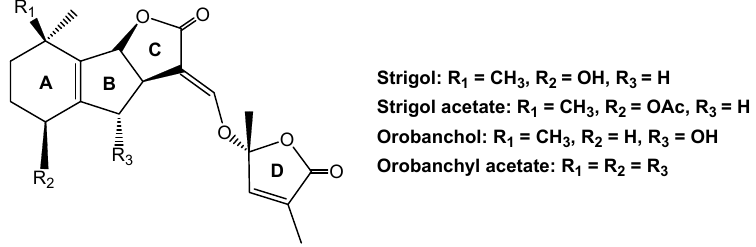
Figure 6. Strigol derivatives that are produced by the roots of host and non-host plants.